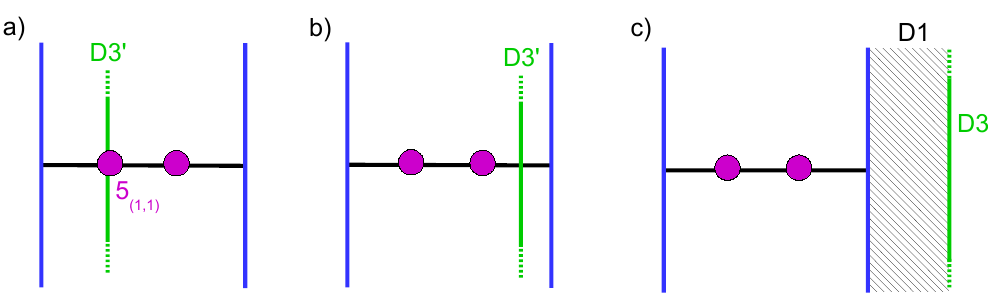
Figure 9 . Moving the D3’( (cid:24) = D3 ) along x 3 we obtain di(cid:11)erent operator insertions, which are (1 ; 0) identi(cid:12)ed on the branch II: (a) X 1 , (b,c) ’ 3 .